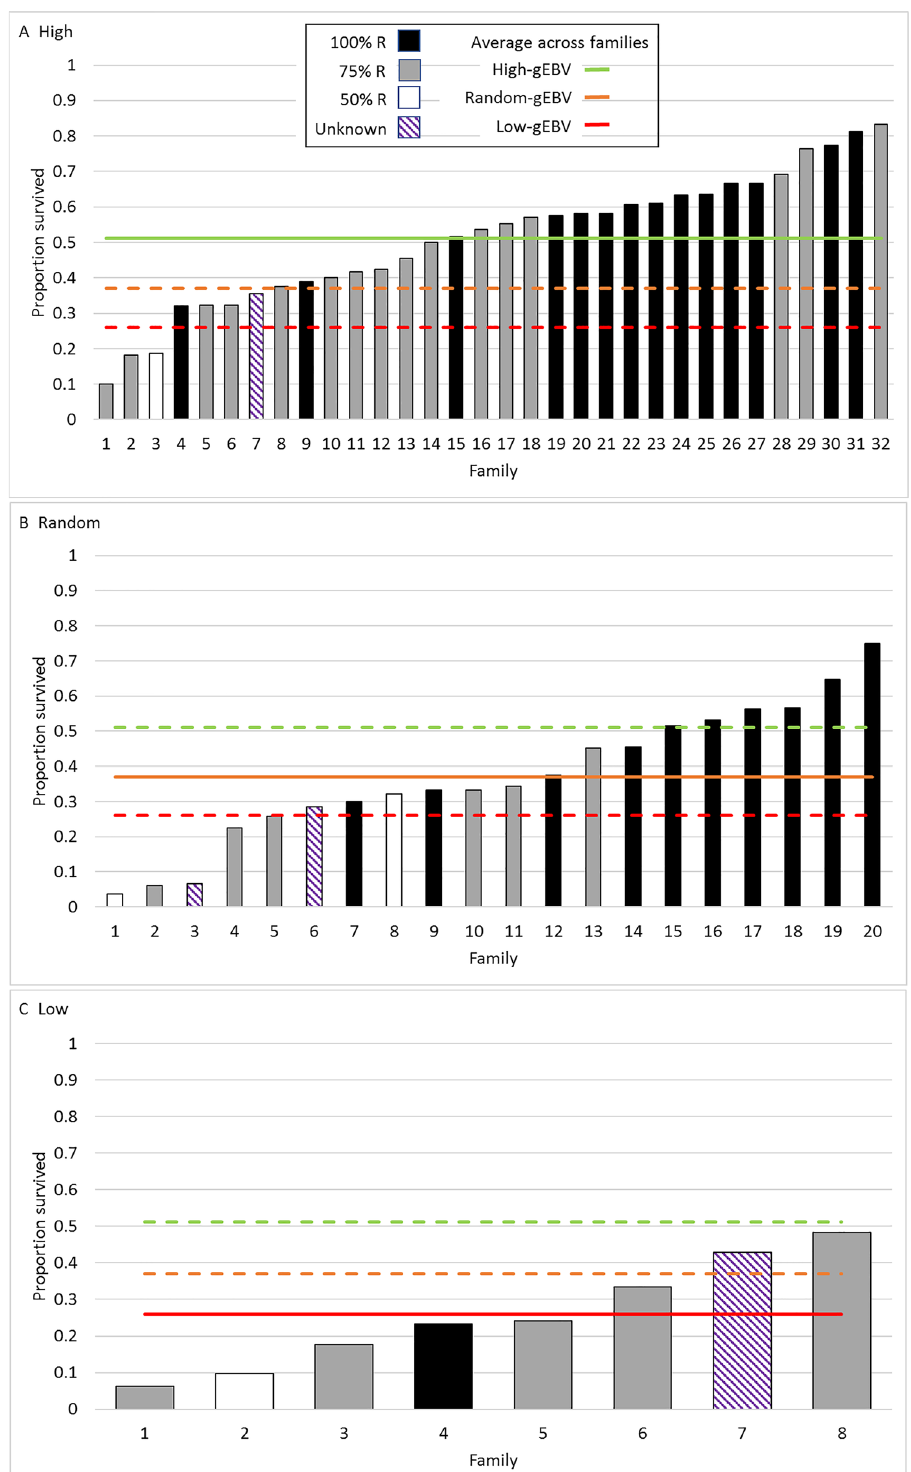
Figure 3. Proportion surviving in each challenged family for high (A) random (B) and low (C) gEBV selected G 1 groups. Shading of the bar plots indicates % of resistant line ancestry in that family (black 100%, grey 75%, white 50% and stripes when the population origin of one parent was unknown. Horizontal lines show the average proportion across families surviving for the high (green), random (orange) and low (red) gEBV G 1 groups. Solid lines relate to the G 1 population that is represented in each